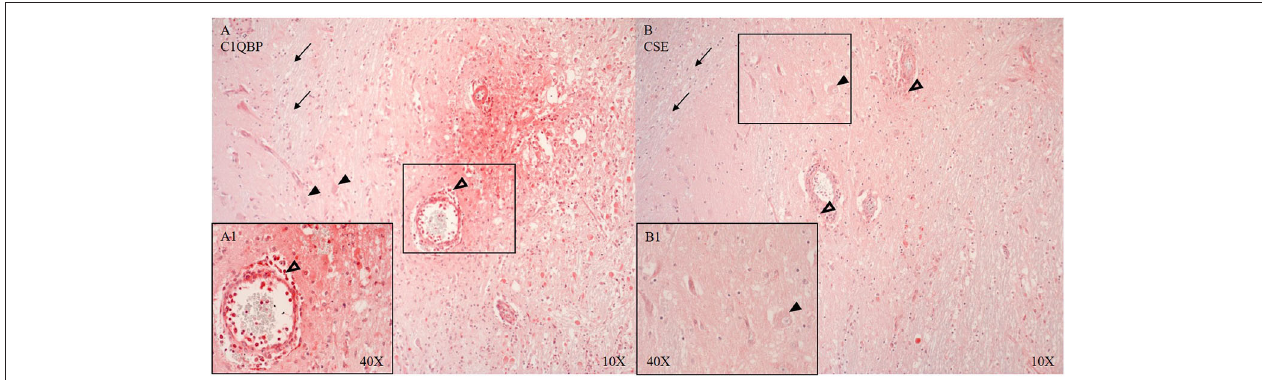
FIGURE 6 | C1QBP ( A, n = 5) and CSE ( B , n = 7) expression in matching consecutive sections of the frontal cortex at the border zone of gray and white matter. Perivascular infiltration of C1QBP and CSE positive immune cells (unfilled arrow heads A,A1,B ), C1QPB expression in the endothelium and SMCs of the microvascular artery (A) (vessel magnified in A1 ) and in the parenchyma with interstitial extravasated erythrocytes (A,A1) . C1QBP and CSE in neurons (black arrow heads) ( A,B magnified in B1 ). CSE expression in the arterial SMCs. White matter is negative for both: C1QBP and CSE (black arrows) (A,B) . C1QBP, complement component 1 Q subcomponent-binding protein; CSE, cystathionine- È -lyase; SMCs, smooth muscle cells.